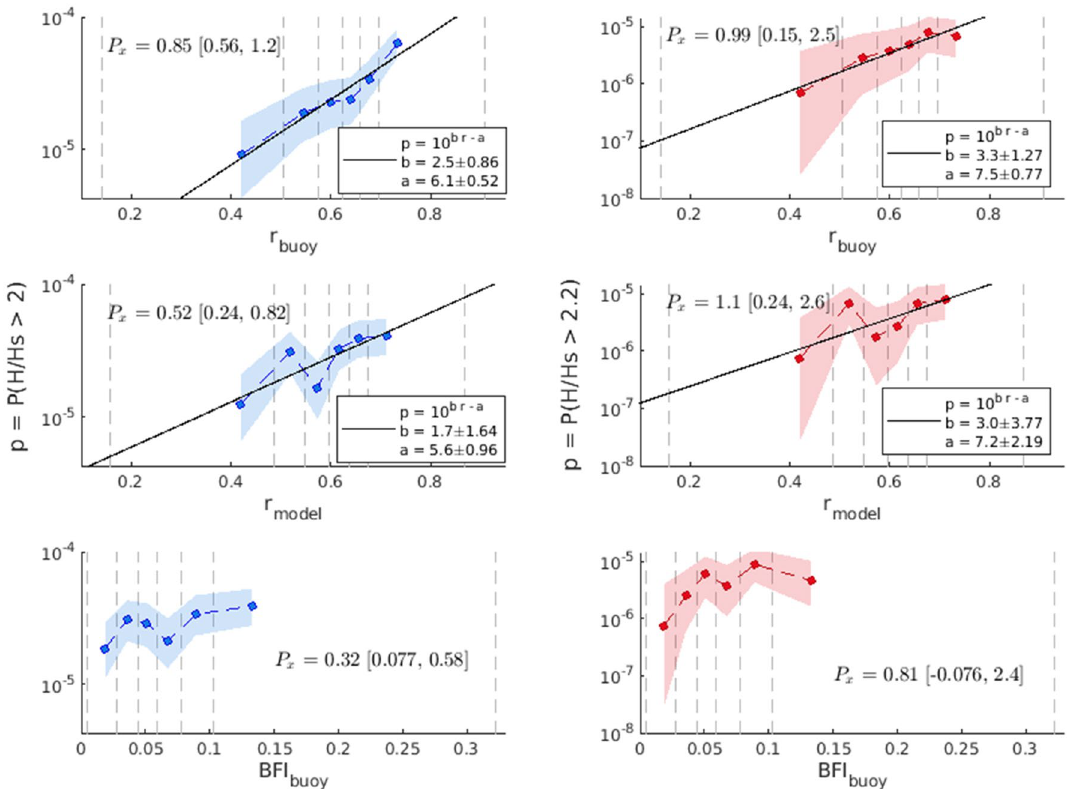
Figure 4. Rogue wave probability as functions of spectral wave parameters. Left column: Probabilities of P ( H / H s > 2 ) . Right column: Probabilities of normalized wave height >2.2, normalized wave height >2.0, p = p P ( H / H s > 2.2 ) . Top row: variability with observed crest-trough correlation r buoy . Middle row: variability = with crest-trough correlation from the model r model . Bottom row: variability with observed Benjamin Feir Index BFI buoy . Shading indicates the 95% credible interval and vertical dashed lines indicate the edges of the parameter bins. Values for predictive power P x and best fit parameters are stated.